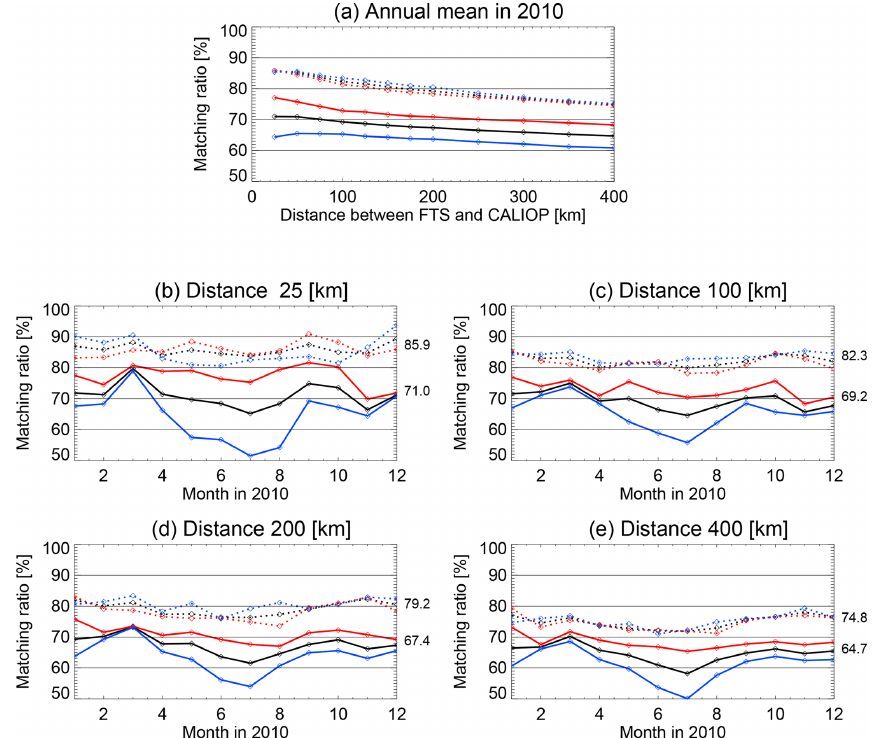
Figure 8. (a) Annual mean matching ratio in 2010 as a function of distance. The solid lines are the whole cloud data, and the dashed lines are for cloud that has cloud top altitude above 5km. The black, red, and blue lines indicate all data (over land, ocean and open water), data over land, and data over ocean, respectively. (b–e) Monthly matching ratio for distances between TANSO-FTS and CALIOP of 25, 100, 200, and 400km. The values on the right-hand side of each panel show the annual